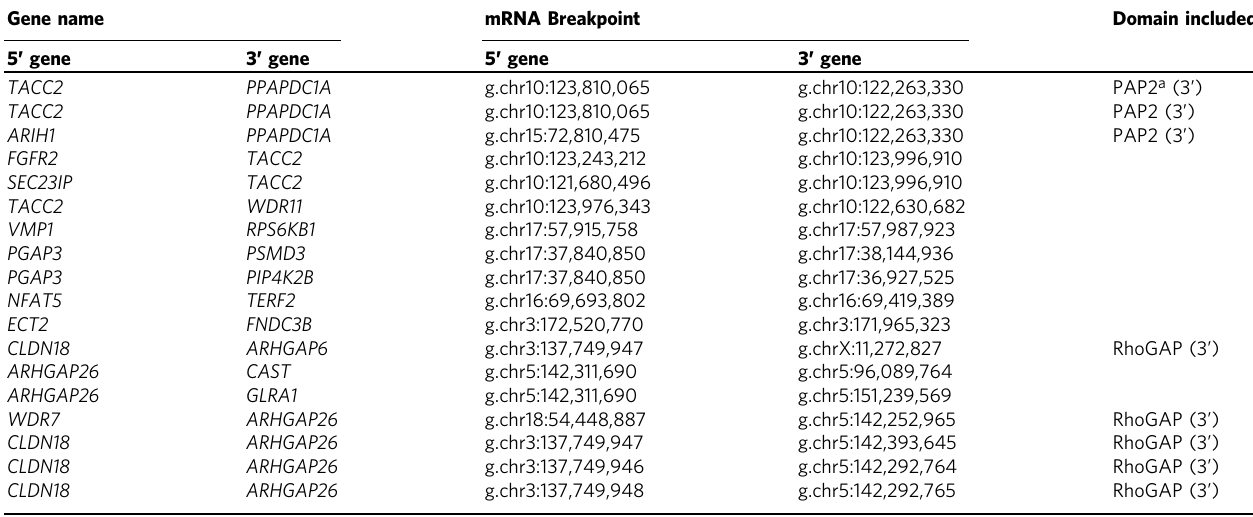
Table 2 In-frame gene fusions additionally identi fi ed by targeted RNA sequencing